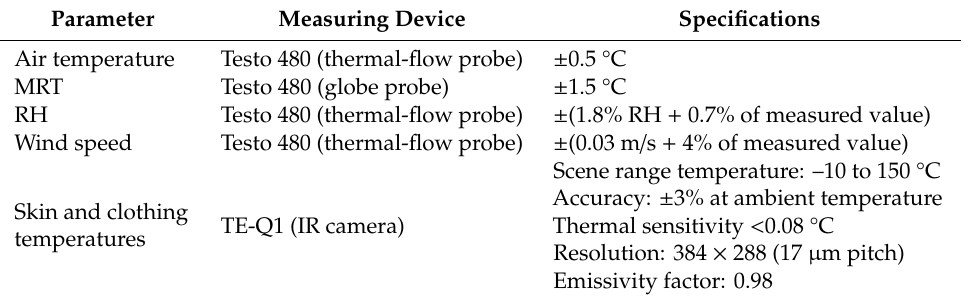
Figure 4. Infrared (IR) camera used in the experiments.